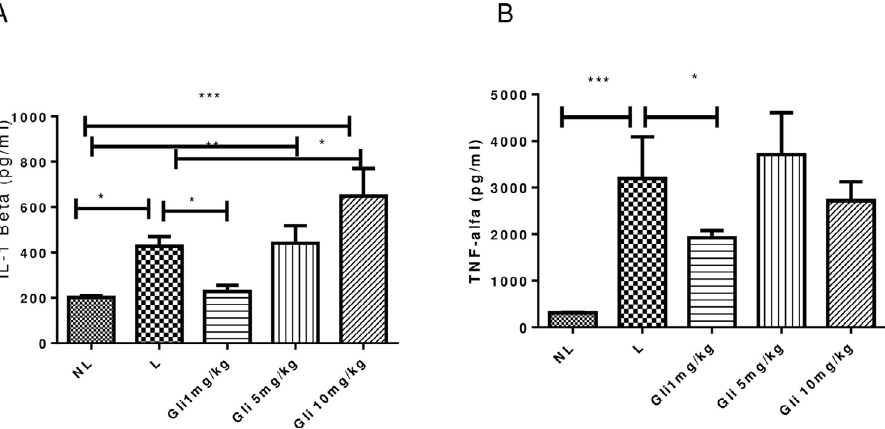
Figure 9- Levels of (A) IL-1β and (B) TNF- α in gingival tissue in the no ligature, ligature, and 1, 5, and 10 mg/kg gliclazide groups. *p<0.05,